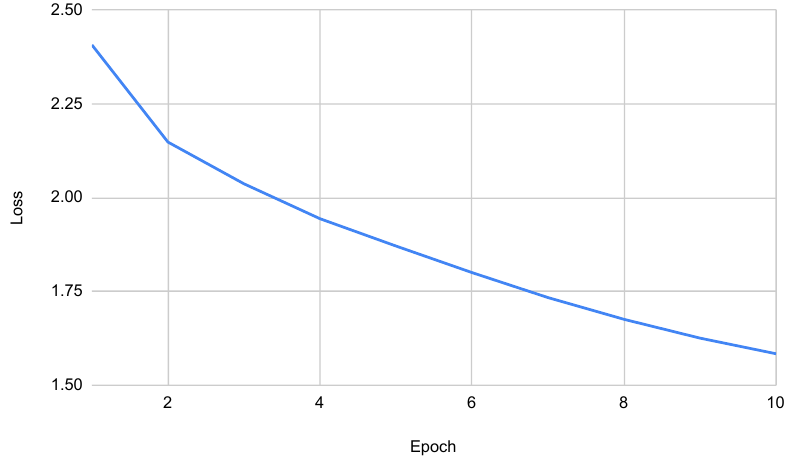
Figure 6. GreekSocialBERT language model training